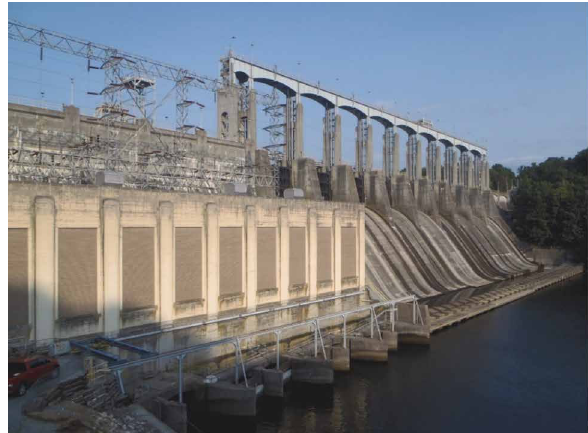
Figure 4. Claytor Hydroelectric facility and dam